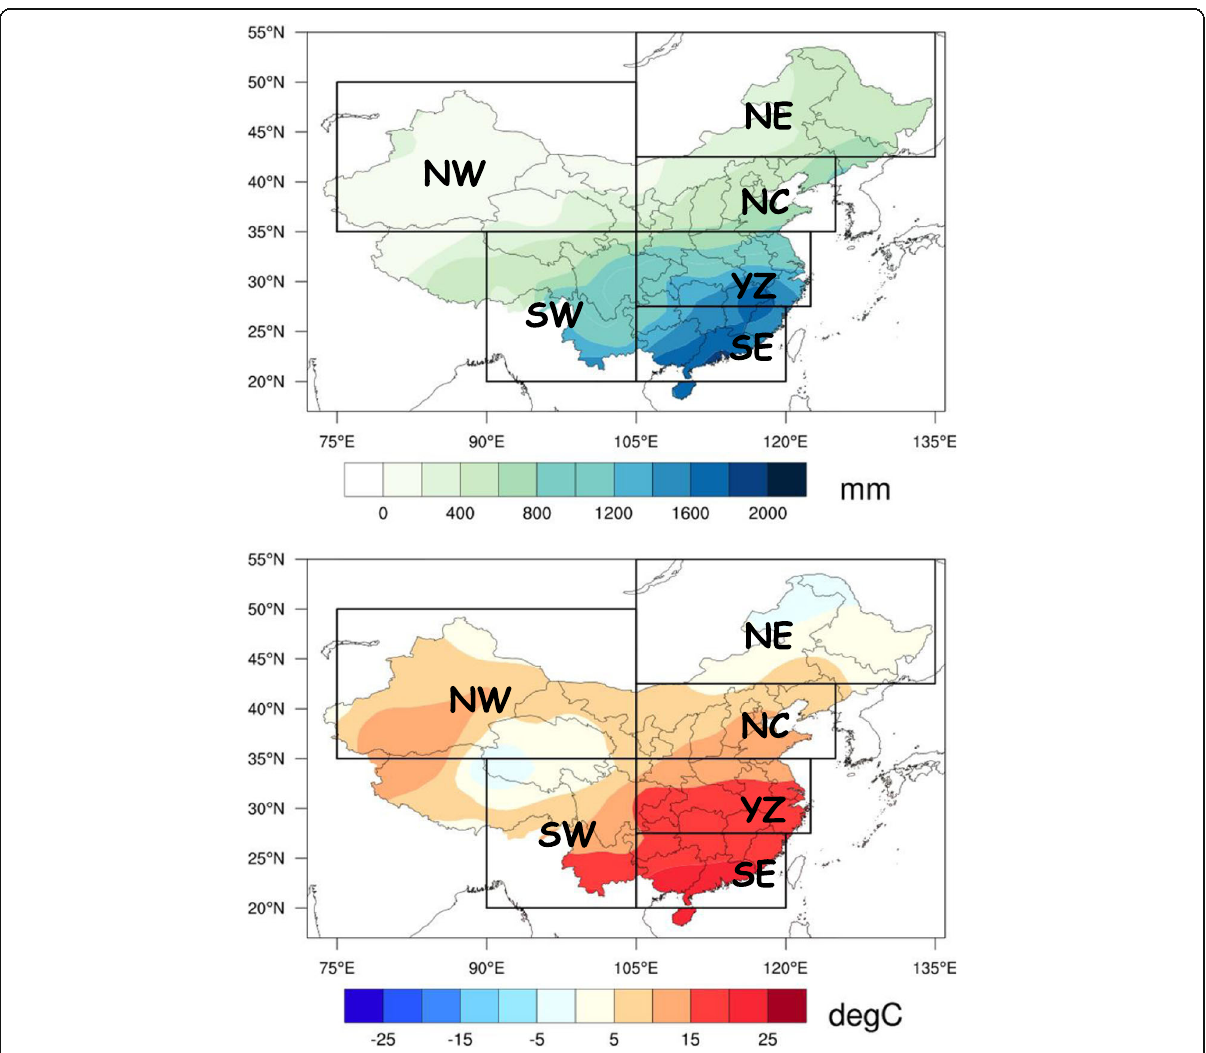
Fig. 1 Six subregions of China: NW (northwest China 35° – 50° N, 74° – 105° E), SW (southwest China 20° – 35° N, 90° – 105° E), NE (northeast China 42° – 55°